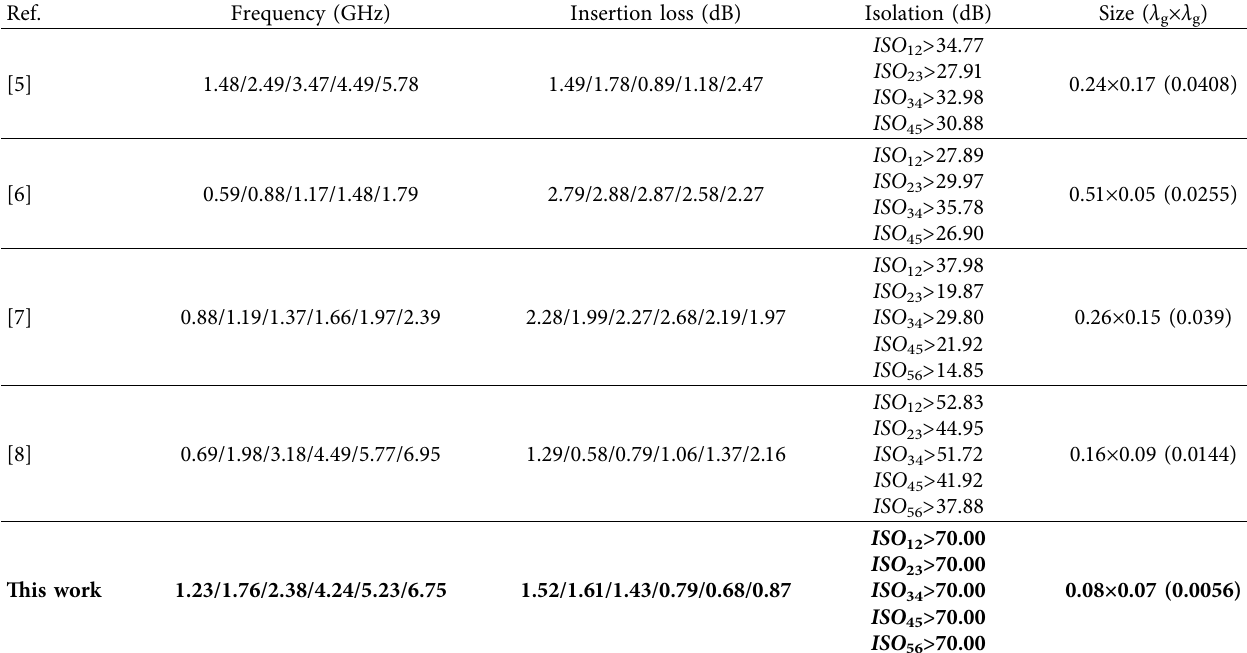
Table 1: Comparison with some previous multi-band